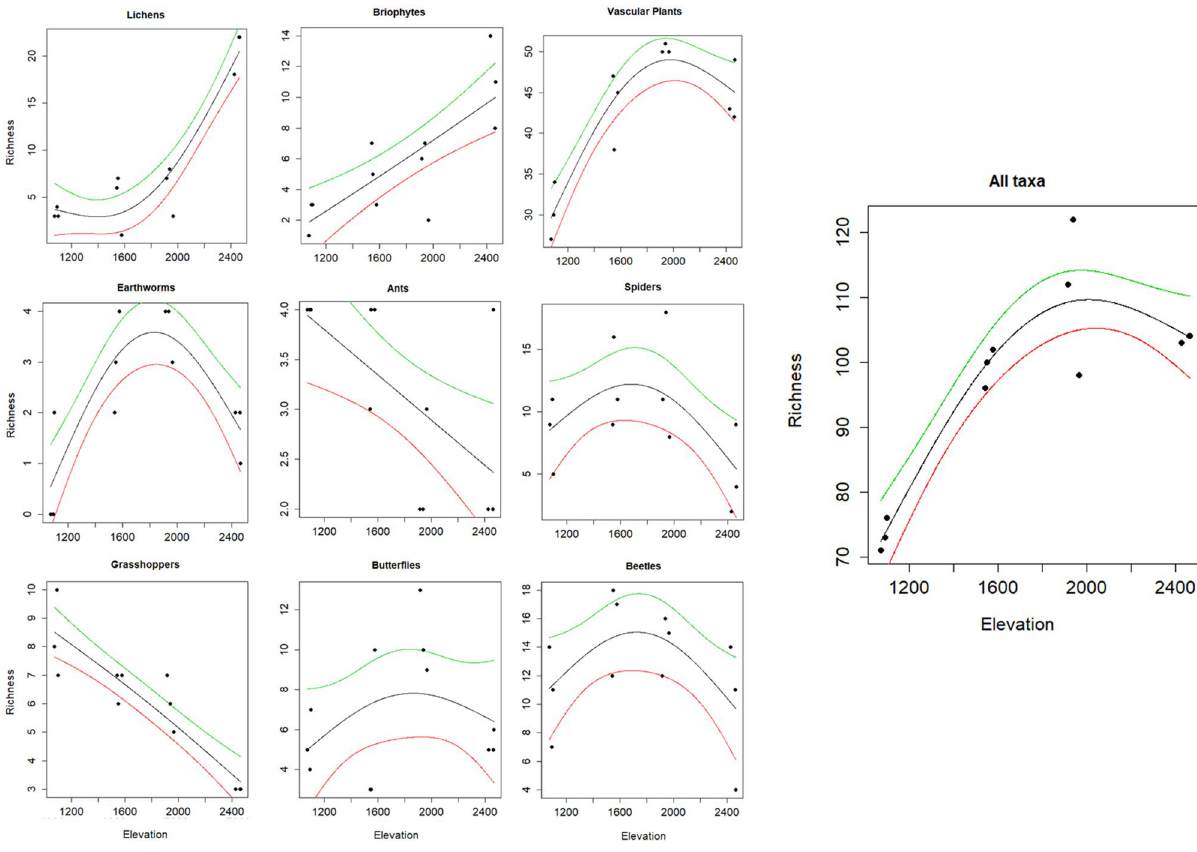
Figure 2. Relationship of species richness and elevation for 9 taxonomic groups. Cumulative number of species per site (n = 12) was calculated for each taxon separately and plotted with a spline-estimated dose–response function with upper (green line) and lower (red line) 95 percent confidence bounds. Figure was produced using R software (version 3.6.2, R Core Team, https ://www.r-proje